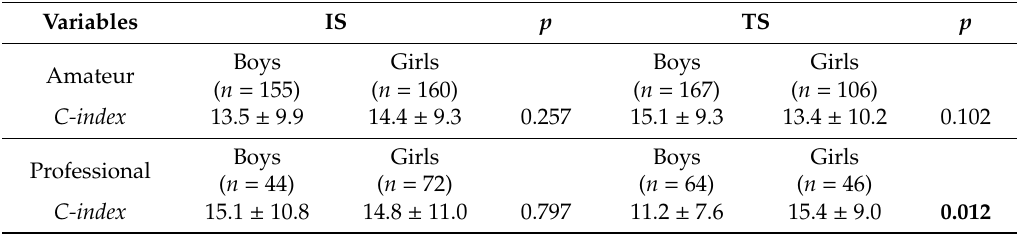
Table 1. Di ff erences (U Mann–Whitney values with mean ± SD) in moral competence C-index (points) between adolescent boys and girls in various modes of involvement in